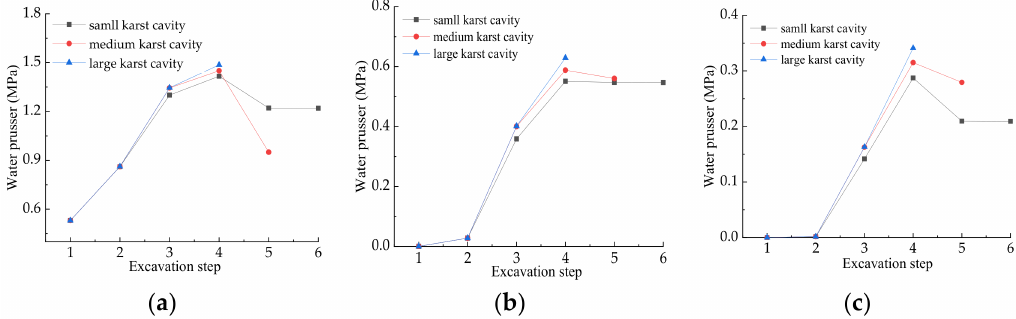
Figure 15. The fluid pressure of di ff erent monitoring points. ( a ) Fluid pressure of monitoring point − 1,0,0; ( b ) Fluid pressure of monitoring point − 3,0,0; ( c ) Fluid pressure of monitoring point −